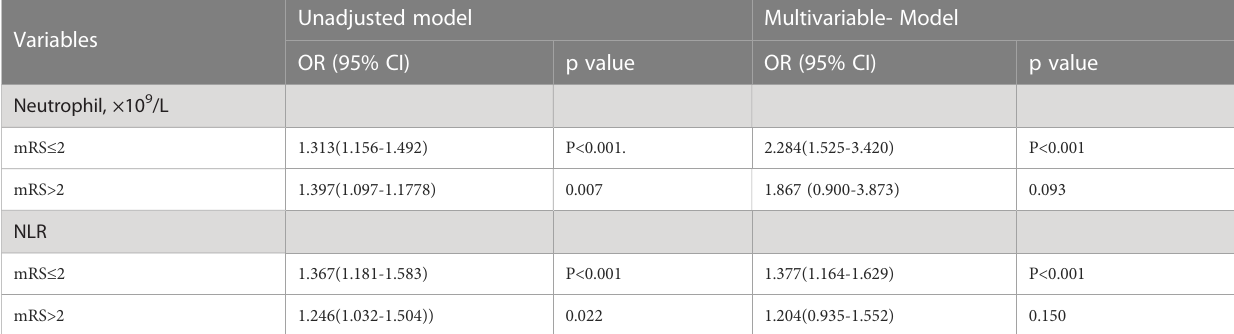
TABLE 5 Unadjusted and adjusted analyses of neutrophil and NLR with high SHR group according to 90 days functional outcomes subgroup.